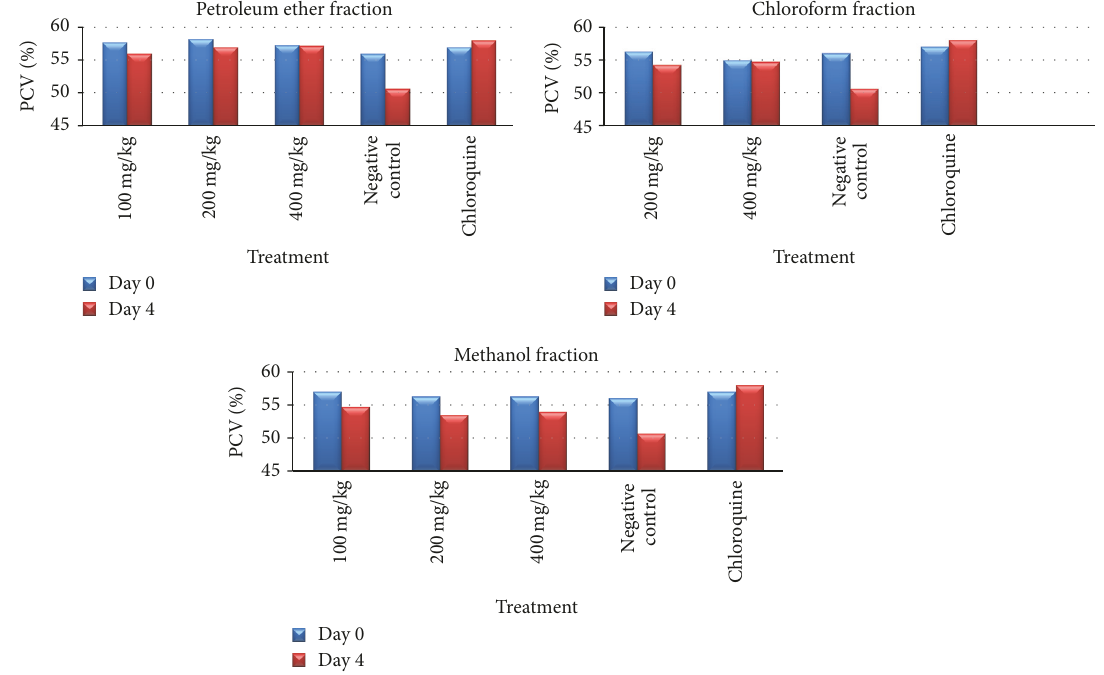
Figure 1: Effect of the solvent fractions of C. papaya fruit rind on packed cell volume (PCV) of P. berghei infected mice on 4-day Peter’s suppression test.